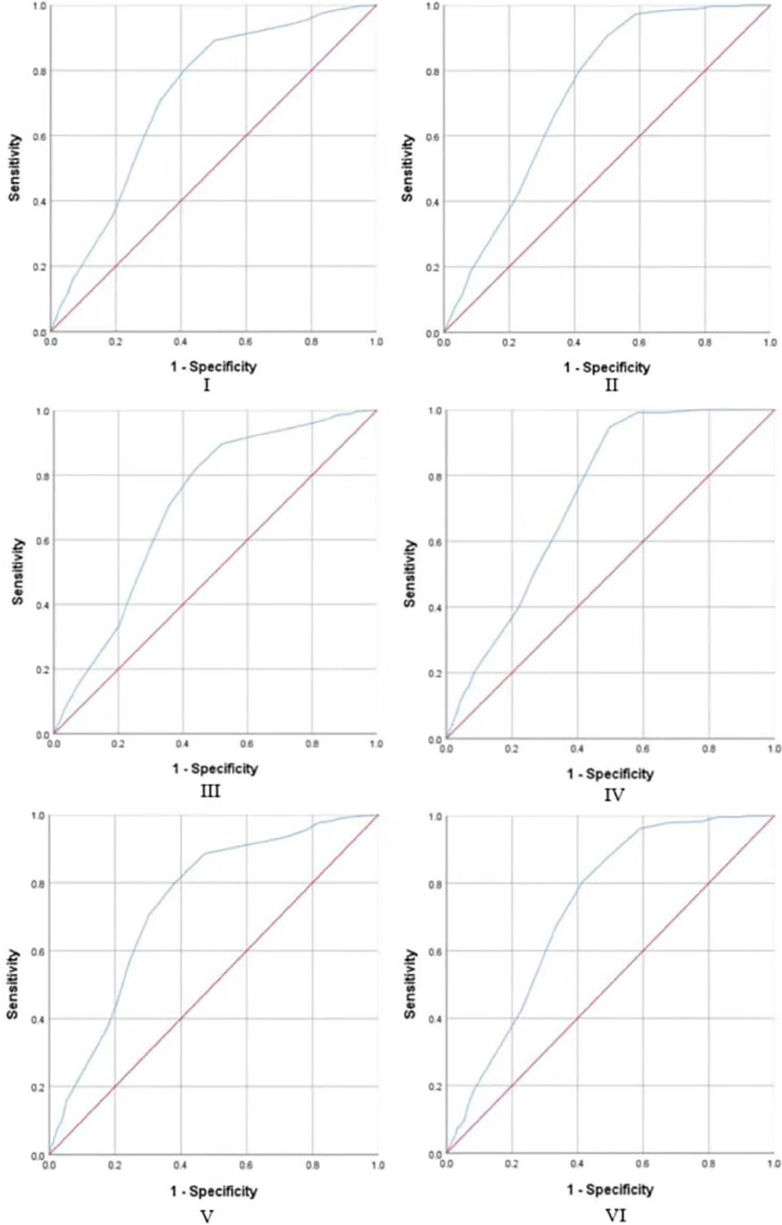
Figure 3. (I ) ROC curve for the EBS-SF score in predicting the overweight or obesity of all participants; ( II ) ROC curve for the EBS-SF score in predicting the obesity of all participants; ( III ) ROC curve for the EBS-SF score in predicting the overweight or obesity of females; ( IV ) ROC curve for the EBS-SF score in predicting the obesity of females; ( V ) ROC curve for the EBS-SF score in pre- dicting the overweight or obesity of males; ( VI ) ROC curve for the EBS-SF score in predicting the obesity of males.